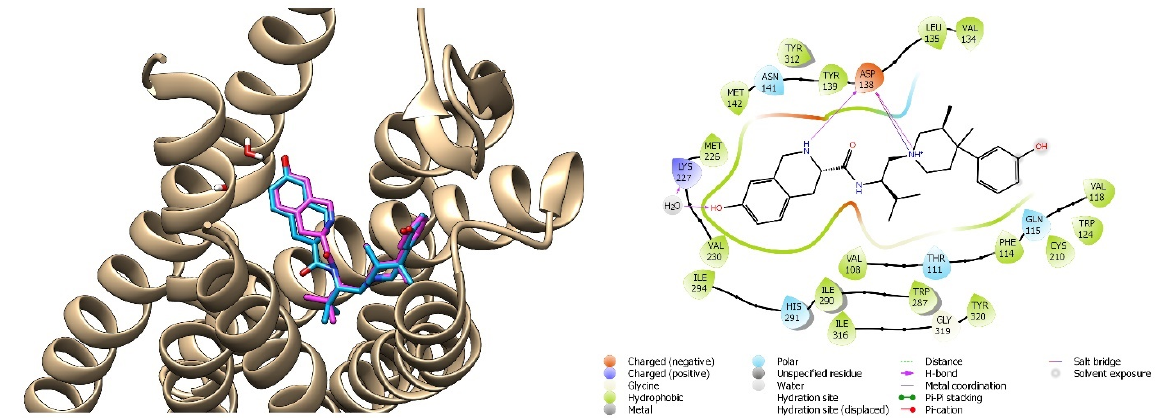
Figure 15. On the left: superimposition of the crystallographic ligand’s pose JDTic (pink) on the crystallized complex and its binding pose obtained with GLIDE/XP (blue); on the right: interactions of the HTVS binding pose of JDTic in the KOR binding cavity.